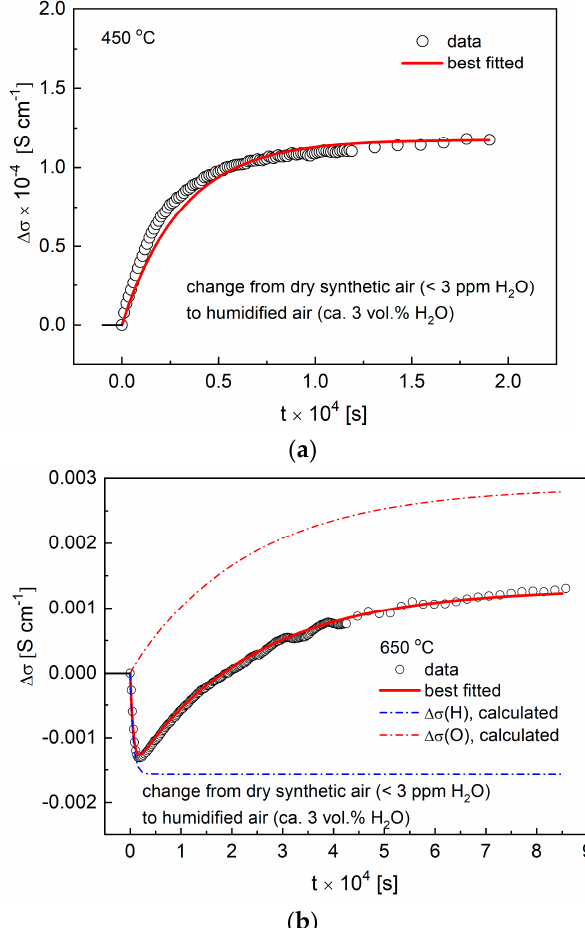
Figure 9. ( a ) Electrical conductivity relaxation (ECR) data with fit recorded at 450 °C during change of the atmosphere from dry to humidified air; ( b ) ECR data with fit recorded at 650 °C during change of the atmosphere from dry to humidified air.